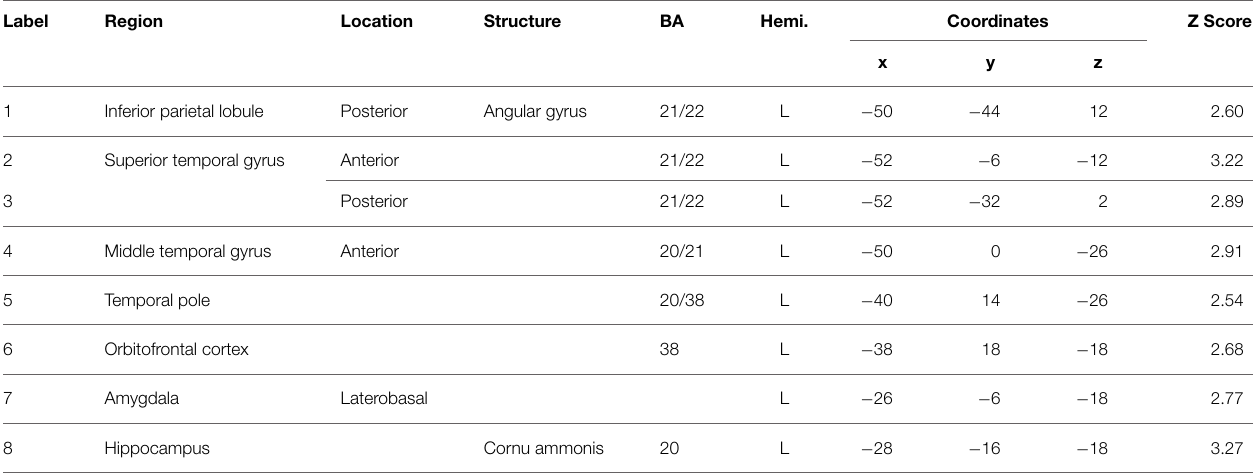
TABLE 4 | Brain regions showing significantly greater RS for themes expressed through dance relative to themes expressed through pantomime ( p < 0 . 05 , cluster corrected in FSL). Label Location Structure BA Hemi. Coordinates Z